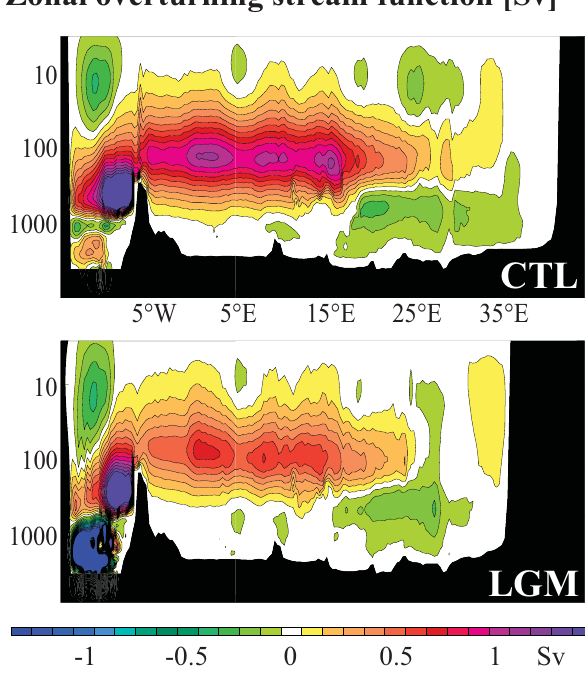
Fig. 12. Meridionally integrated zonal overturning stream function in Sv. Positive values indicate clockwise circulation. The x-axis shows longitude, the y-axis depth in m on a logarhithmic scale. The top panel shows CTL, the bottom panel LGM. Contour value is 0.1Sv, white indicates values smaller than ± 0.05Sv.